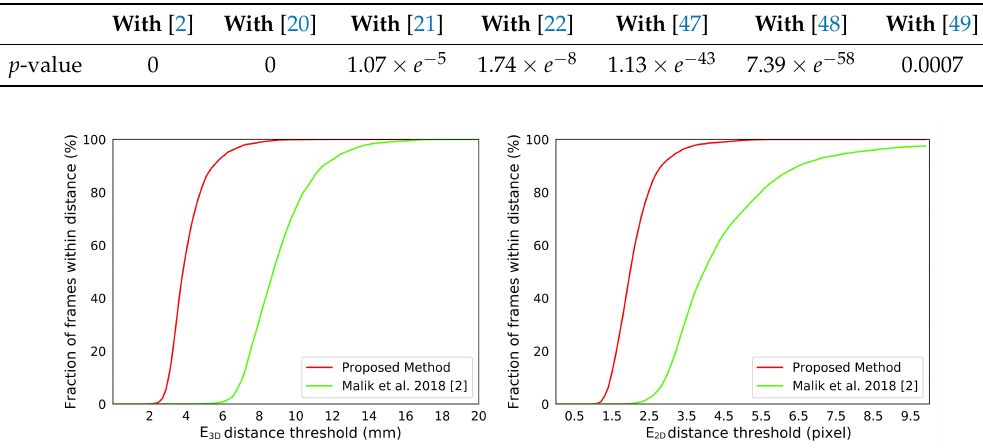
Table 6. The results of significance tests between our system with [2,20–22,47–49] on the joints error of the NYU data-set.